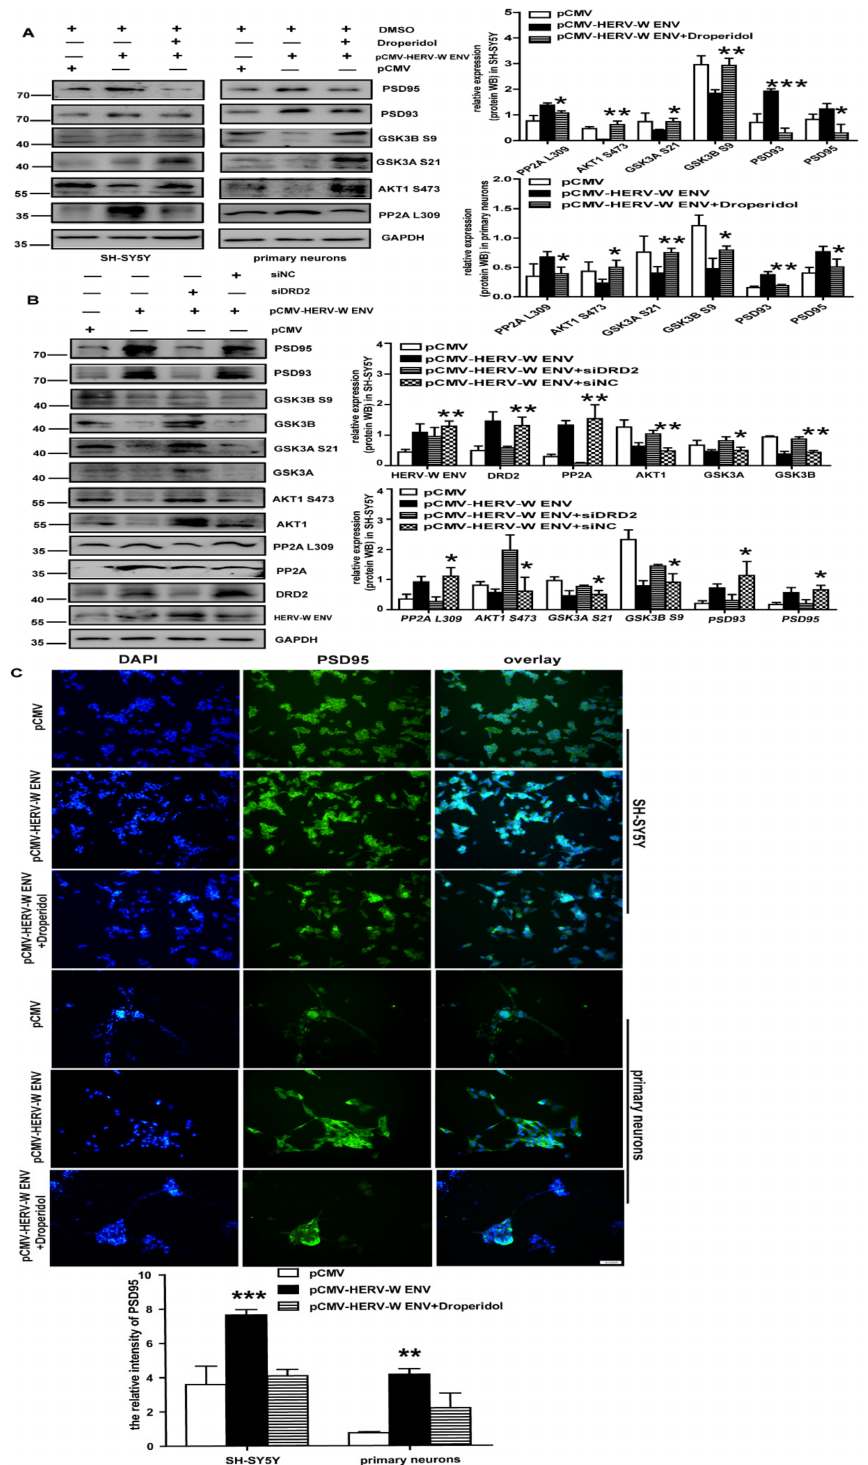
Figure 6. HERV-W ENV regulates the PP2A/AKT1/GSK3 signal pathway via DRD2: ( A ) the DRD2 was down-regulated and its downstream proteins were upregulated after using Droperidol (inhibitor of DRD2) in the DA neurons. ( B ) The PP2A was downregulated and its downstream proteins were regulated after down-regulating DRD2 by DRD2 siRNA in SH-SY5Y cells. ( C ) Immunofluorescence staining of PSD95. The immunofluorescence was higher in the HERV-W ENV overexpression group and then recovered by Droperidol by cellular immunofluorescence. Each experiment was performed three times with a representative result shown. * p < 0.05, ** p < 0.01, *** p <